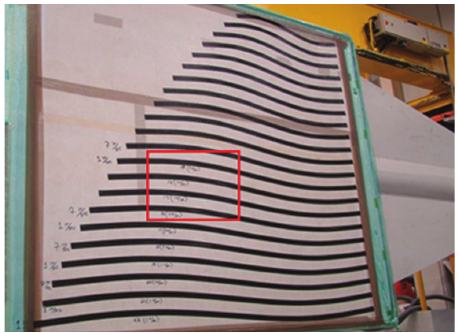
Figure 14 Fiber steering trial 2: sinusoidal fiber paths.